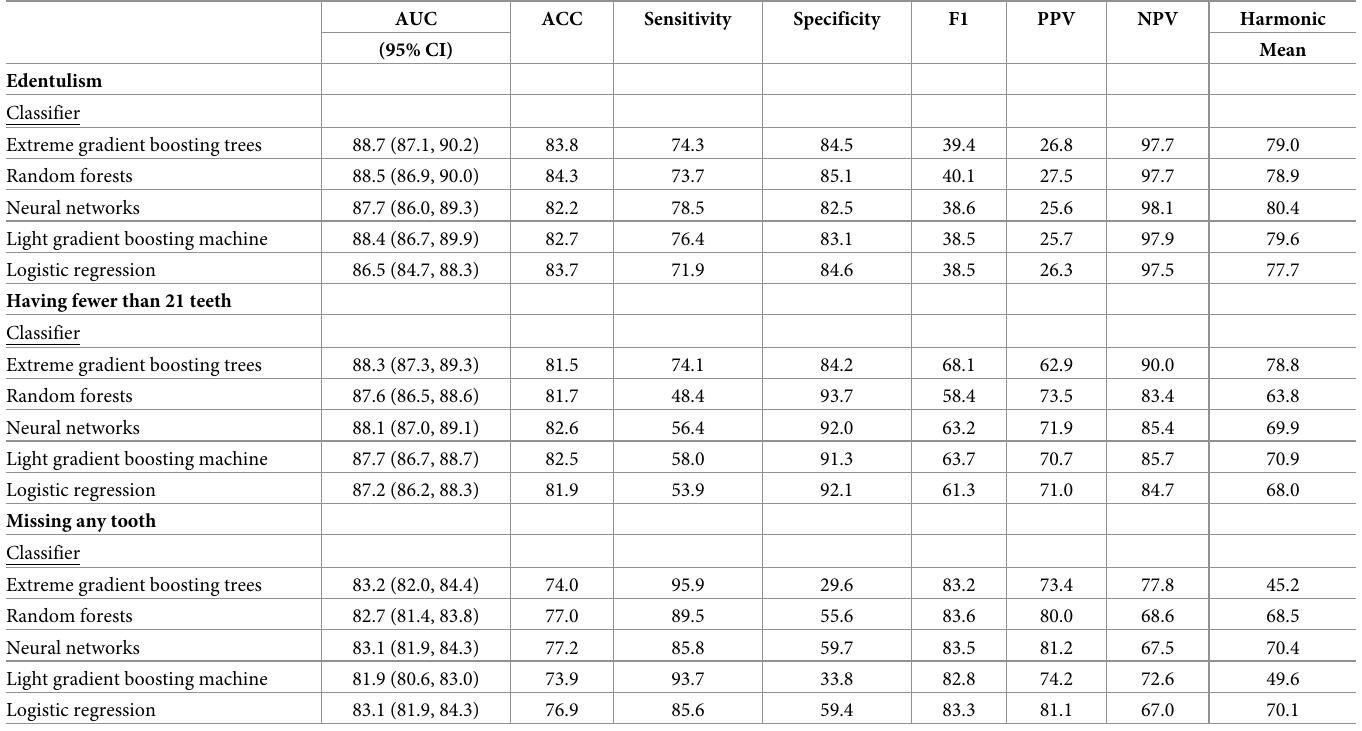
Table 2. Performance of the machine-learning algorithms on the test data for each study